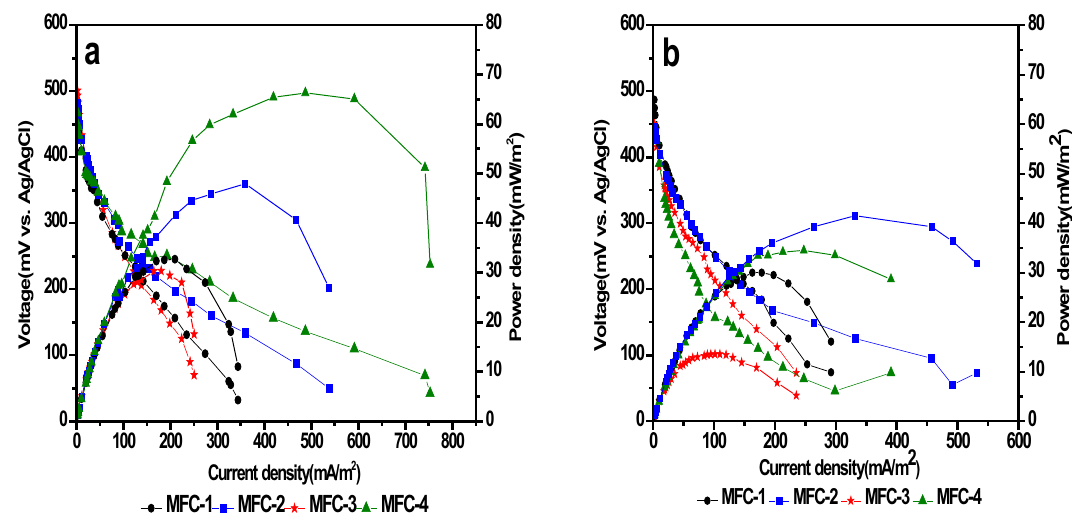
Fig. 3 Polarization curve obtained after a six cycles, b ten cycles, respectively Fig. 4 Electrode potentials obtained after a six cycles, b ten cycles,